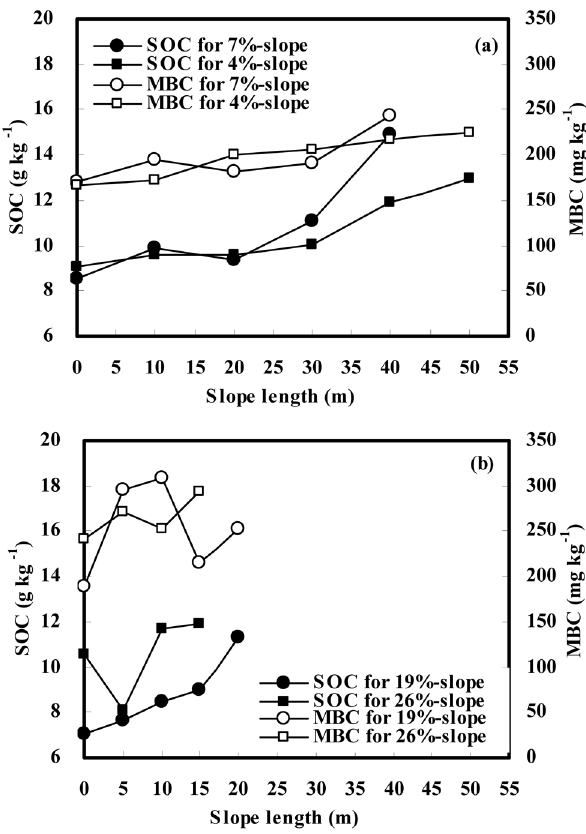
Figure 4. SOC contents vs. 137 Cs inventories in gentle and steep slope